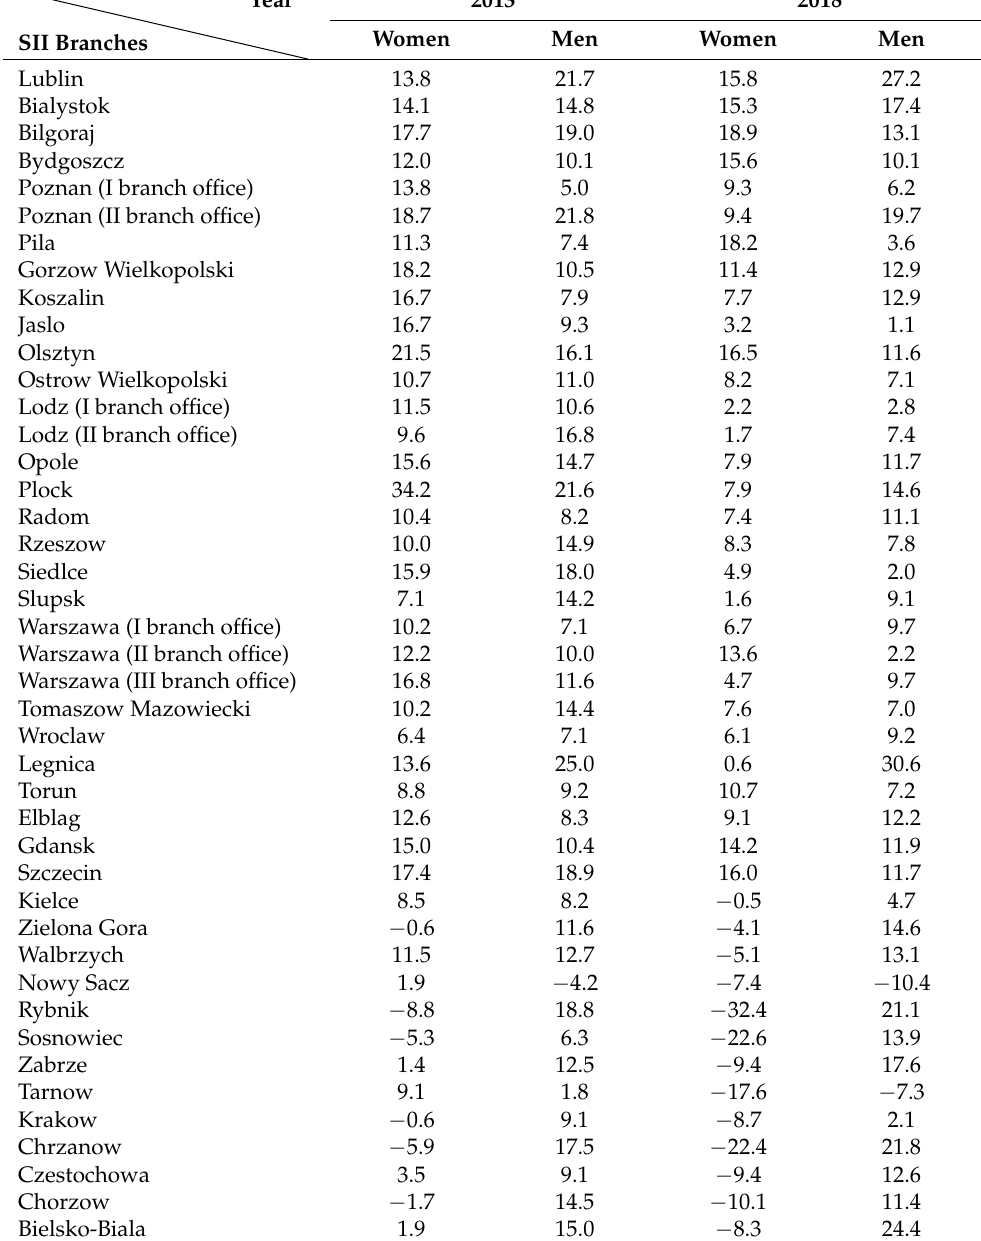
Table 3. Income and life expectancy ratio by Social Insurance Institution (SII) branches (in %).